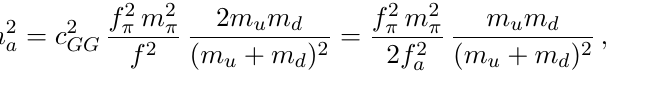
/m = 0 . 49 ± 0 . 02 and 2 m u d